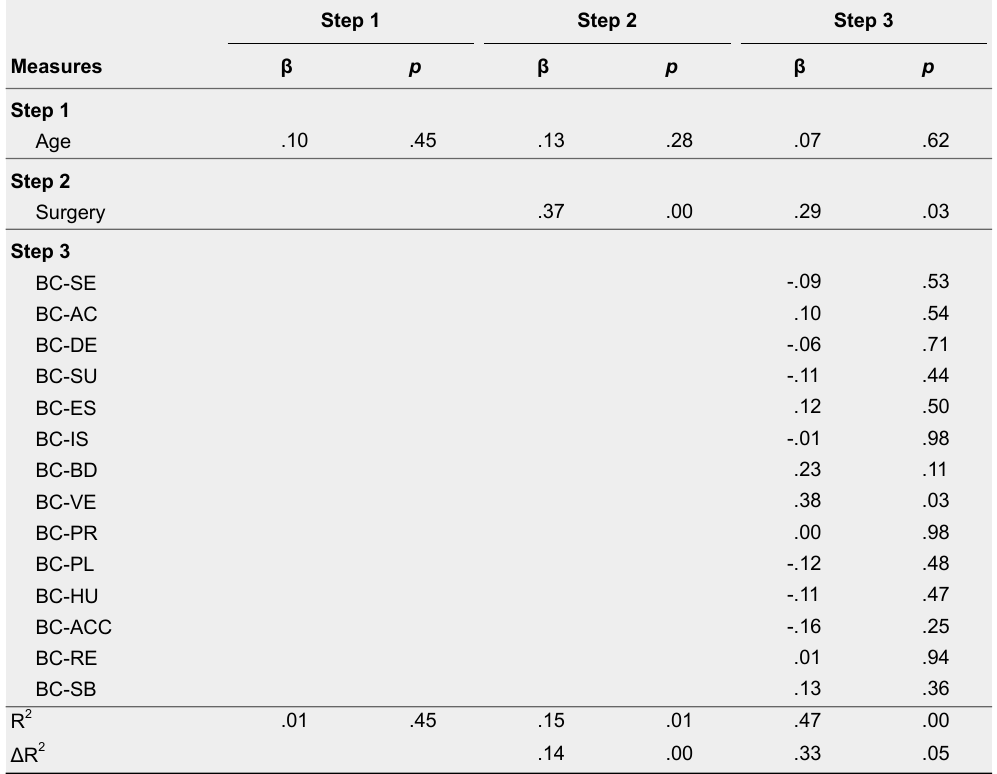
Hierarchical Multiple Regression of